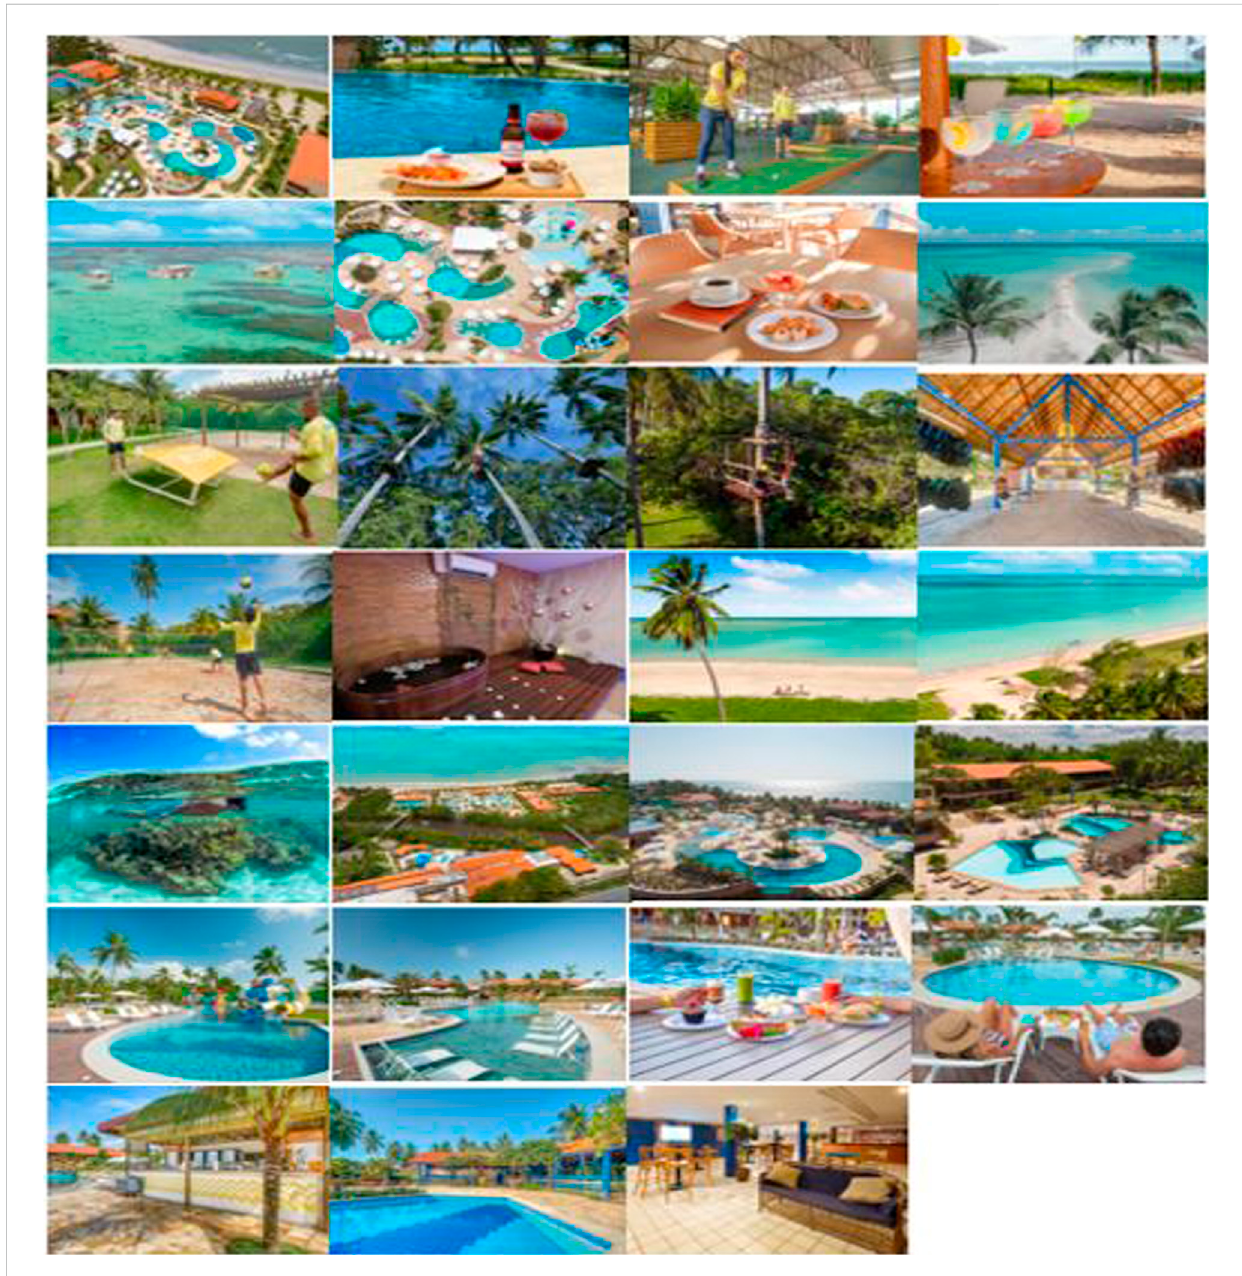
FIGURE 6 Photoproduction of Salinas Maragogi health resort, Brazil; Source: Ekhaese and Ndimako (2022).